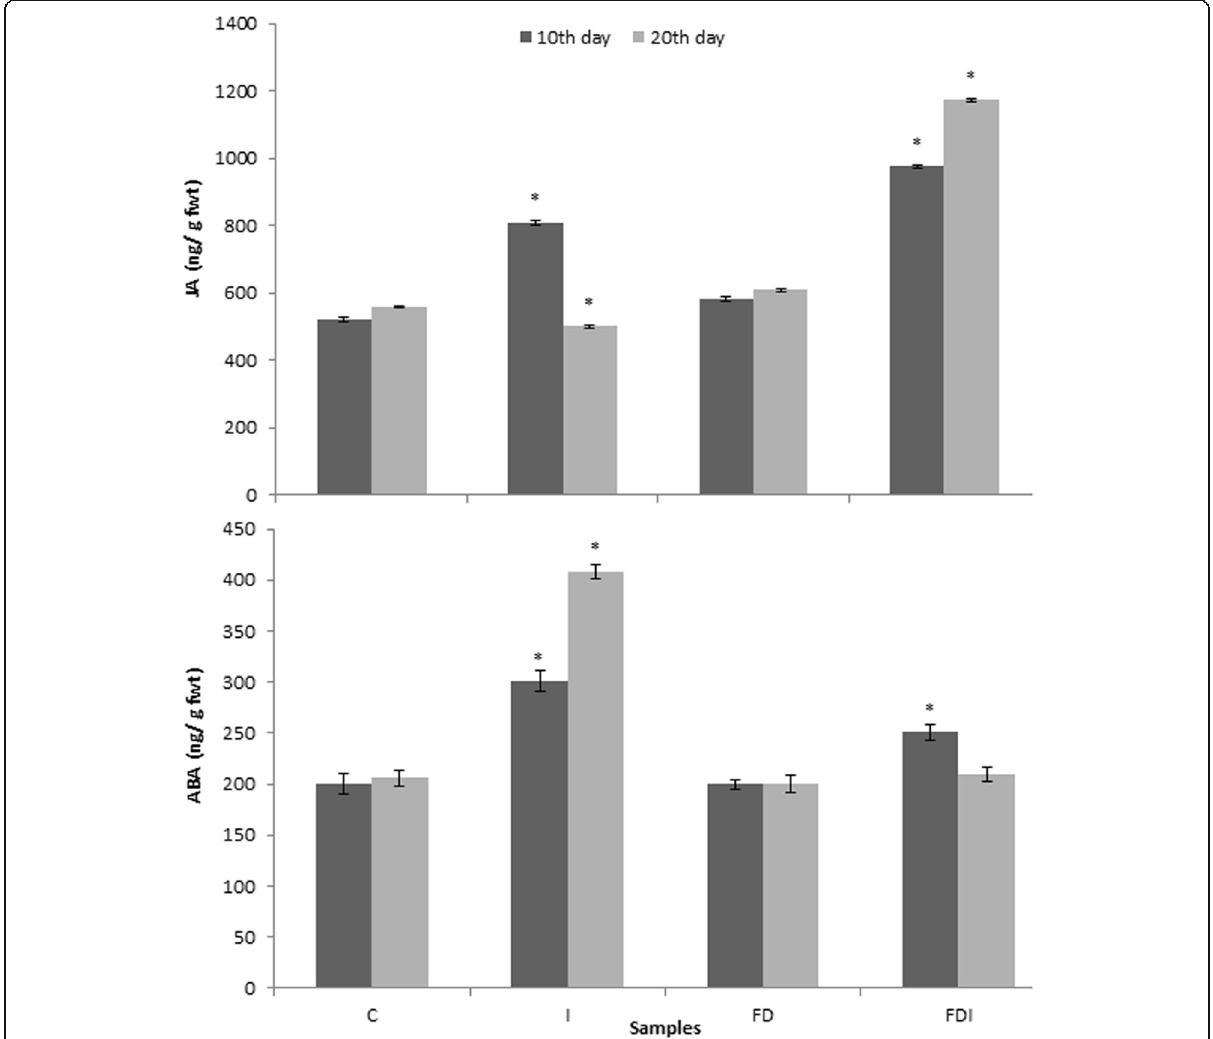
Fig. 6 Effect of defensin priming on Hormones content (JA and ABA) in plants under Fusarium infection. C: Control plants (plants grown from non- primed grains in non-infected soil, FD: plants grown from defensin primed grains in non-infected soil, I: plants grown from non-primed grains in Fusarium infected soil and FDI: plants grown from defensin primed grains in Fusarium infected soil. The columns followed by asterisks are significantly different from the control according to paired-samples t test. The bars represent the standard error. Values are means of three